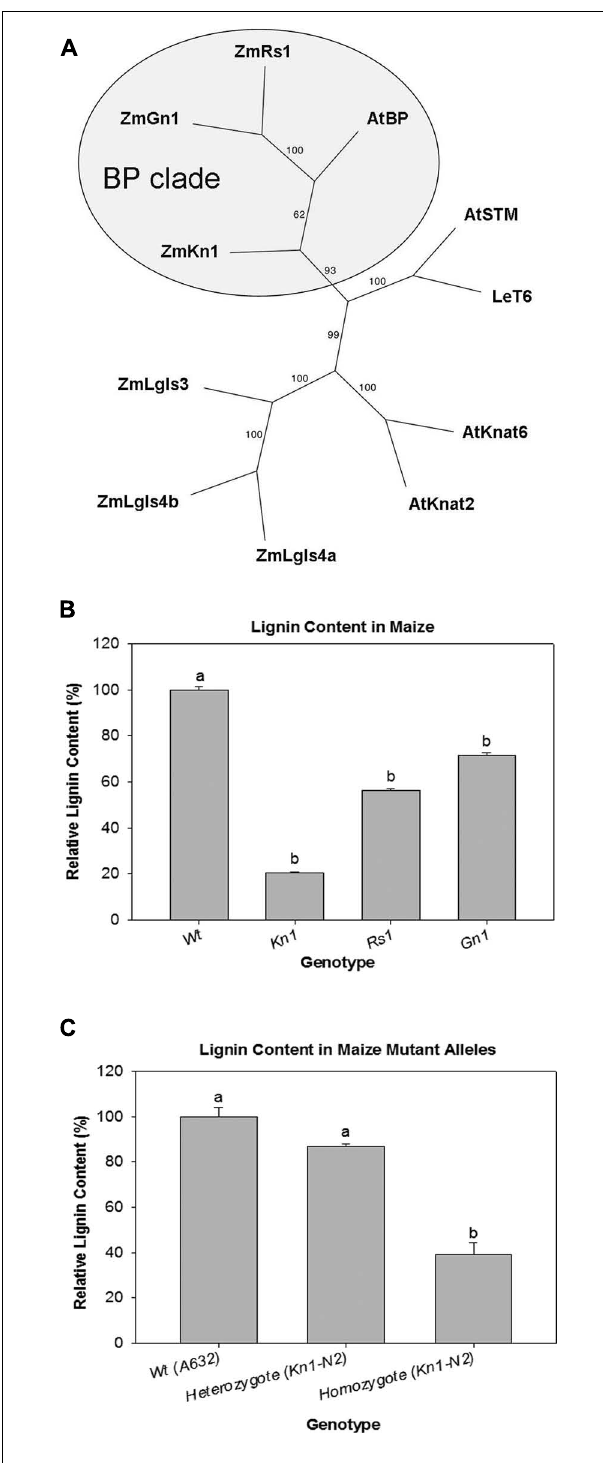
FIGURE 1 | (A) Cladogram depicting the phylogenetic position of LeT6 and Knotted1 among maize and Arabidopsis KNOX1 genes. (B) Relative lignin content in wild-type (Wt) maize and overexpression mutants of Knotted1 ( Kn1 ), Roughsheath1 ( Rs1 ), and Gnarley1 ( Gn1 ). (C) Dosage effect of Kn1-N2 mutant allele. Lignin is more reduced in homozygous Kn1-N2 plants than in Kn1-N2 heterozygous orWt plants. Error bars in (B) and (C) represent standard error ( ± SE; N = 4). P <